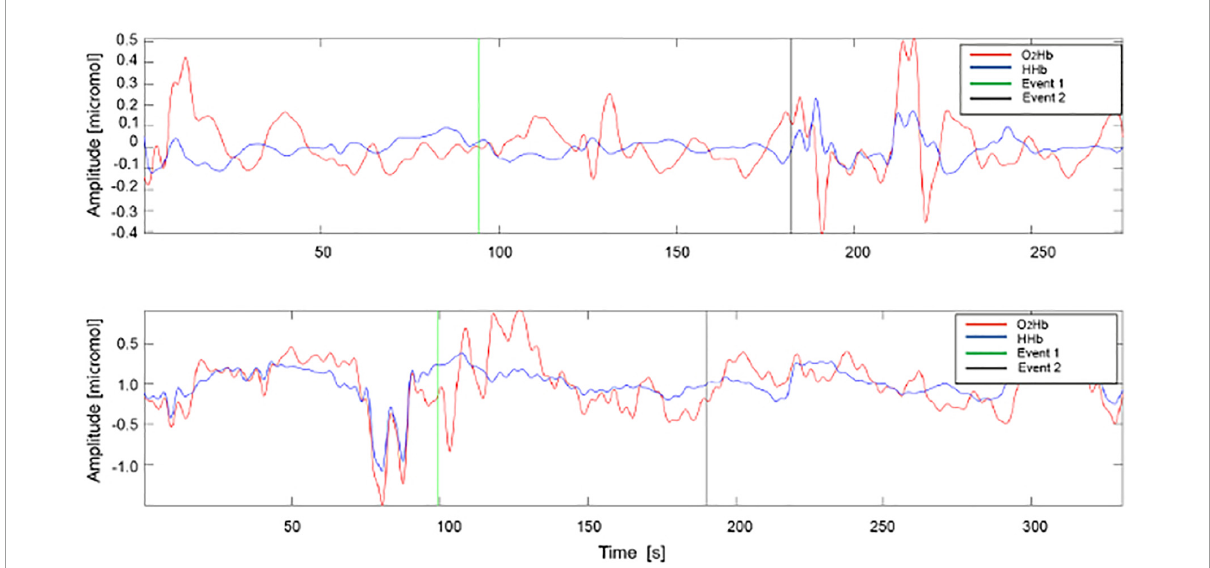
FIGURE2 Example of acquisition of O 2 Hb and HHb signals in AK before (A) and after (B) treatment. HHb signals are represented in blue and O 2 Hb signals in red. Event 1: ice application, Event 2: ice